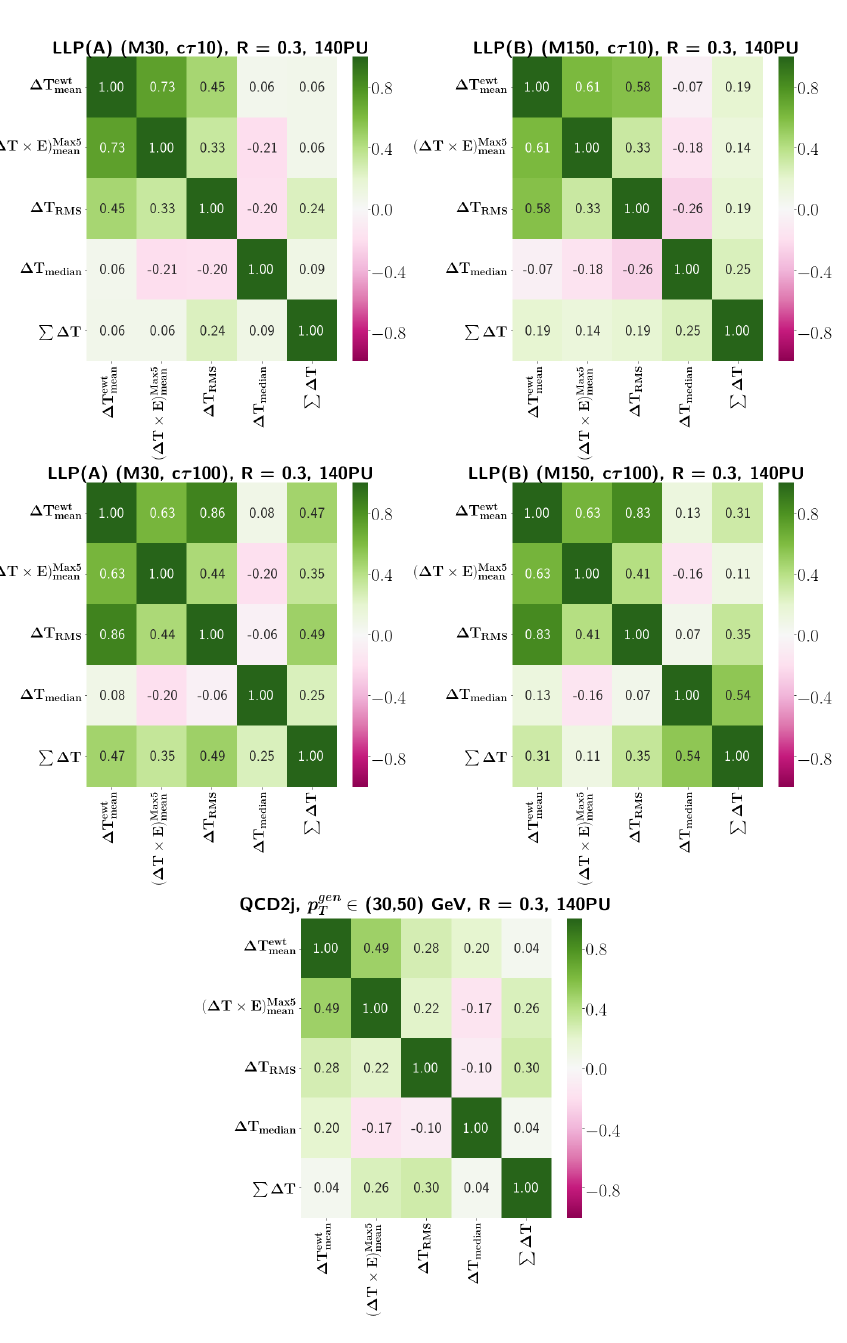
Figure 13 . Correlation between the various timing variables defined in section 5.1 for four benchmark points of LLP — two from scenario (A) with M = 30 GeV, cτ = 10 cm ( top left and cτ = 100 cm X center left ), and two from scenario (B) with M X = 150 GeV, cτ = 10 cm ( top right and cτ = 100 cm center right ), and QCD dijet process ( p T ∈ { 30 , 50 } GeV) ( bottom ) using the resolution corresponding to 1000 fb − 1